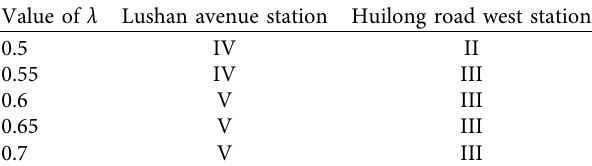
Table 13: Calculation results for different values of λ